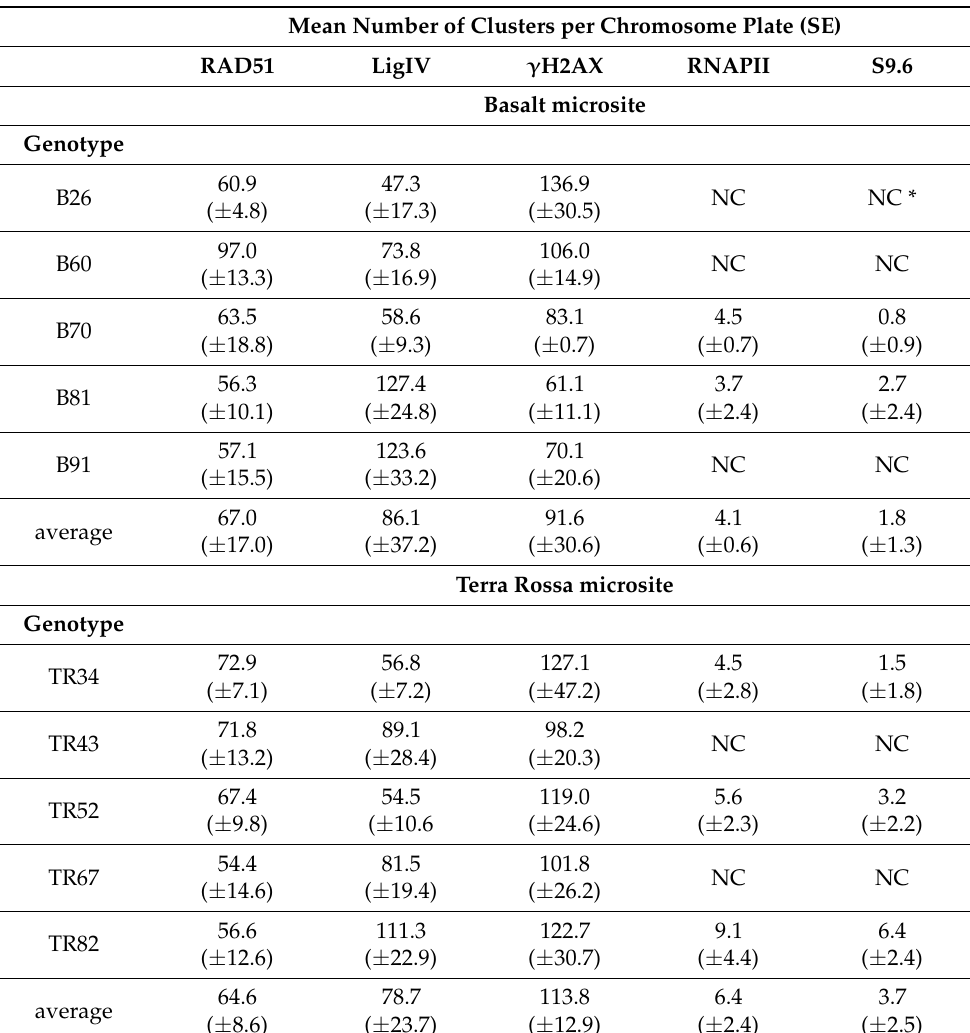
Table 1. Mean number of RAD51, LigIV, γ H2AX, RNAPII, and S9.6 clusters on metaphase chromo- somes in plants of the Basalt (B) and the Terra Rossa (TR) microsites of the Tabigha population. For each genotype, 10 to 11 metaphase plates were analyzed (see Table S1). Mean Number of Clusters per Chromosome Plate